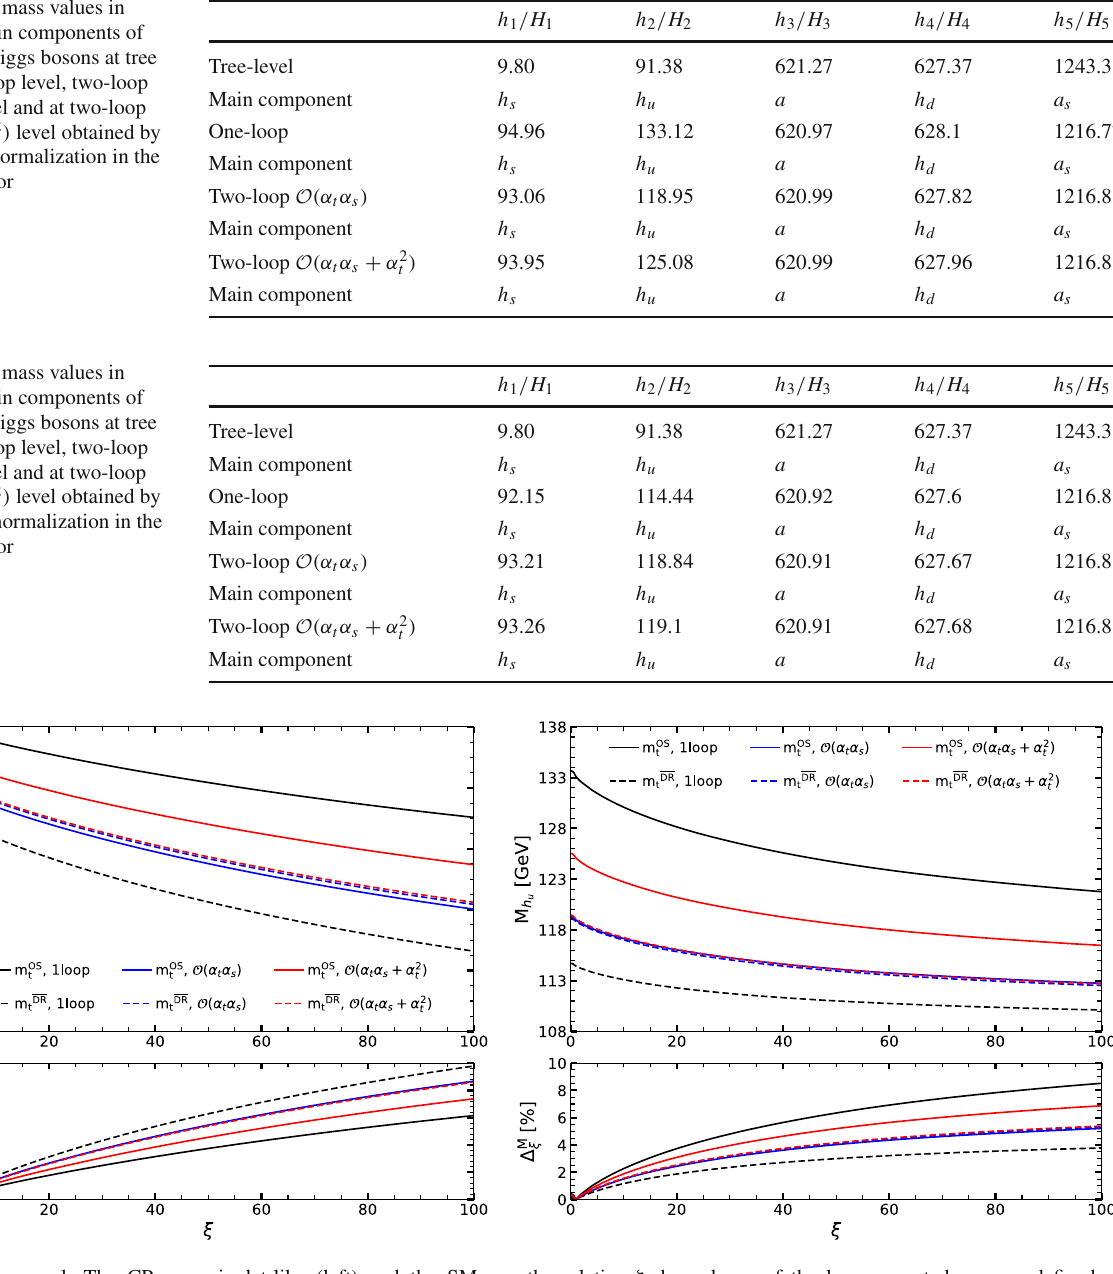
the relative ξ dependence of the loop-corrected masses, defined as (cid:15) M = | M (ξ) − M (ξ = 1 ) | / M (ξ = 1 ) ( x = h , h x x x s u ), in percent, ξ as function of ξ . The color code in the lower plots is the same as in the upper